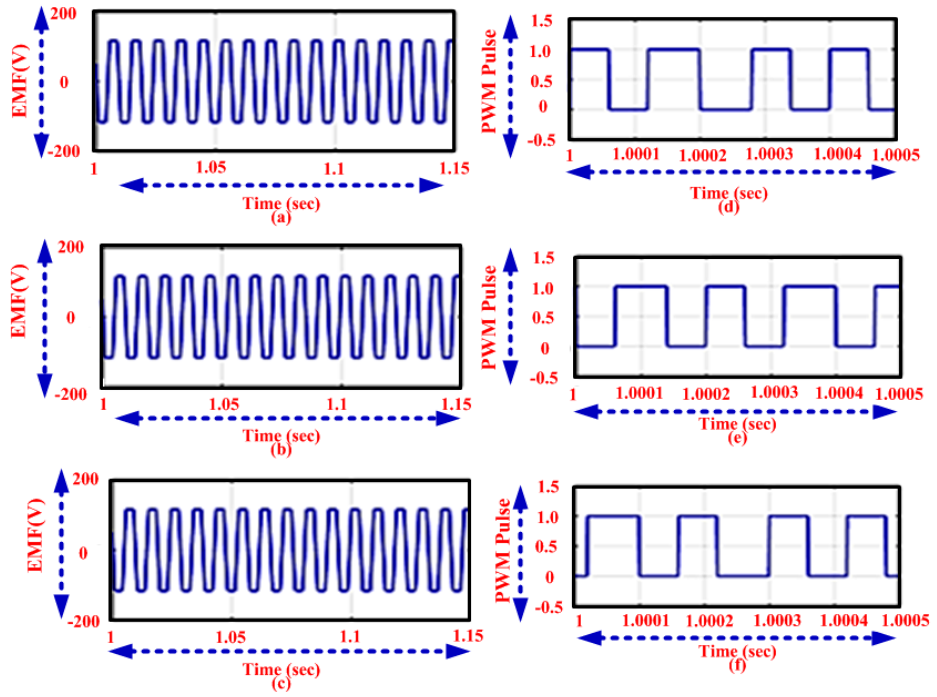
Figure 7. Analysis of EMF using the ( a ) proposed ( b ) MFO method and ( c ) PI controller and pulse width modulation (PWM) using the ( d ) proposed ( e ) MFO method and ( f ) PI